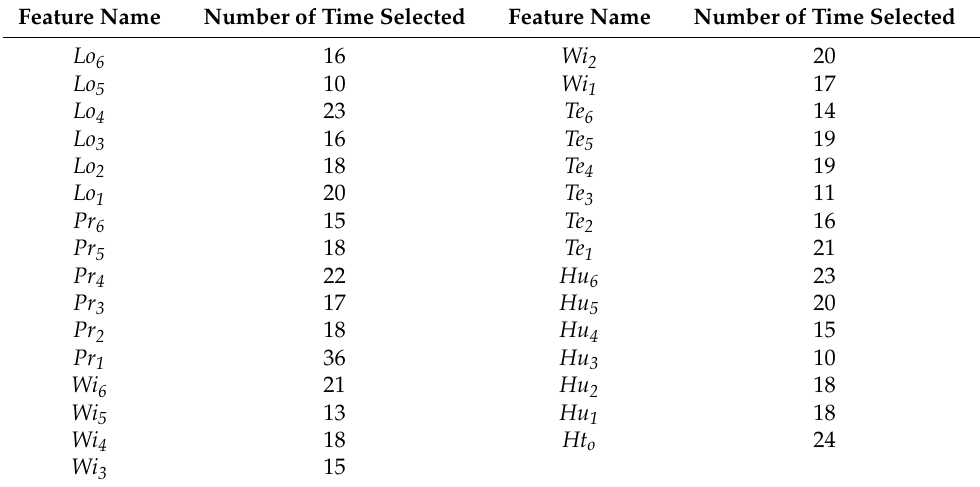
Table 2. Number of feature selected year wise highlighted on the top 10 features selected most times.